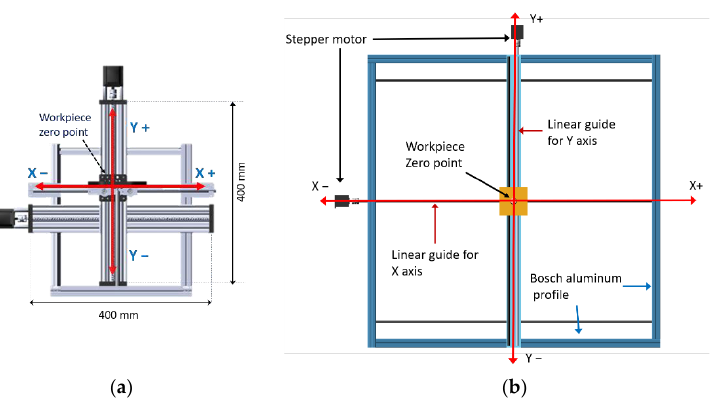
Figure 6. Workpiece zero point in rehabilitation machines: ( a ) Ankle and ( b ) Shoulder.